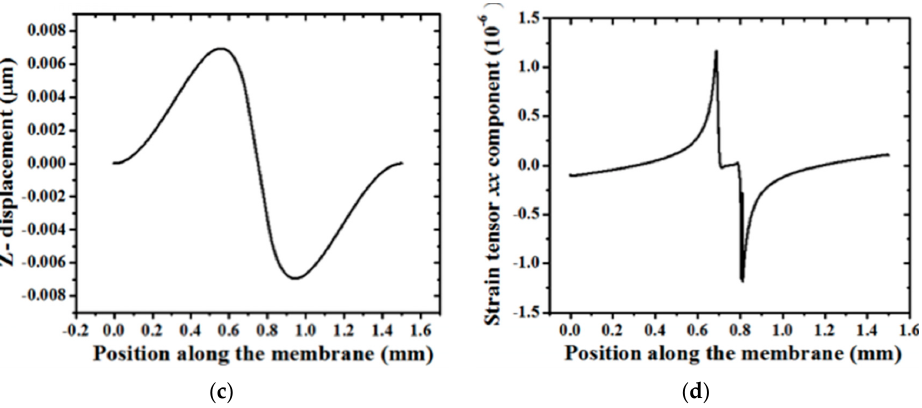
Figure 3. Three-dimensional finite element analysis structural mechanical simulations to determine the stress distribution on the membrane: ( a ) Simulation set-up describing the sensor structure subject to air flow velocity of 1 m/s (hair cell sensor geometry and material parameters set to real case); ( b ) Displacement mapping on the LCP membrane; ( c ) Displacement profile along the central axis (diameter) of the membrane; ( d ) Strain distribution along the membrane.